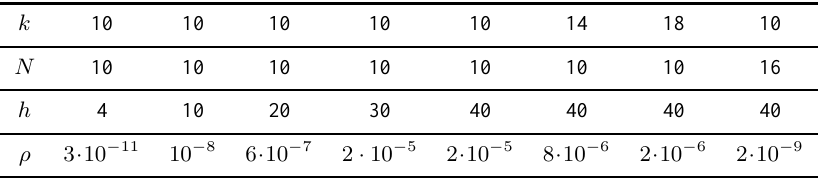
Table 8. Example 1 ( r 1 = 3 ; r 2 = 2 ; j = 2 ).